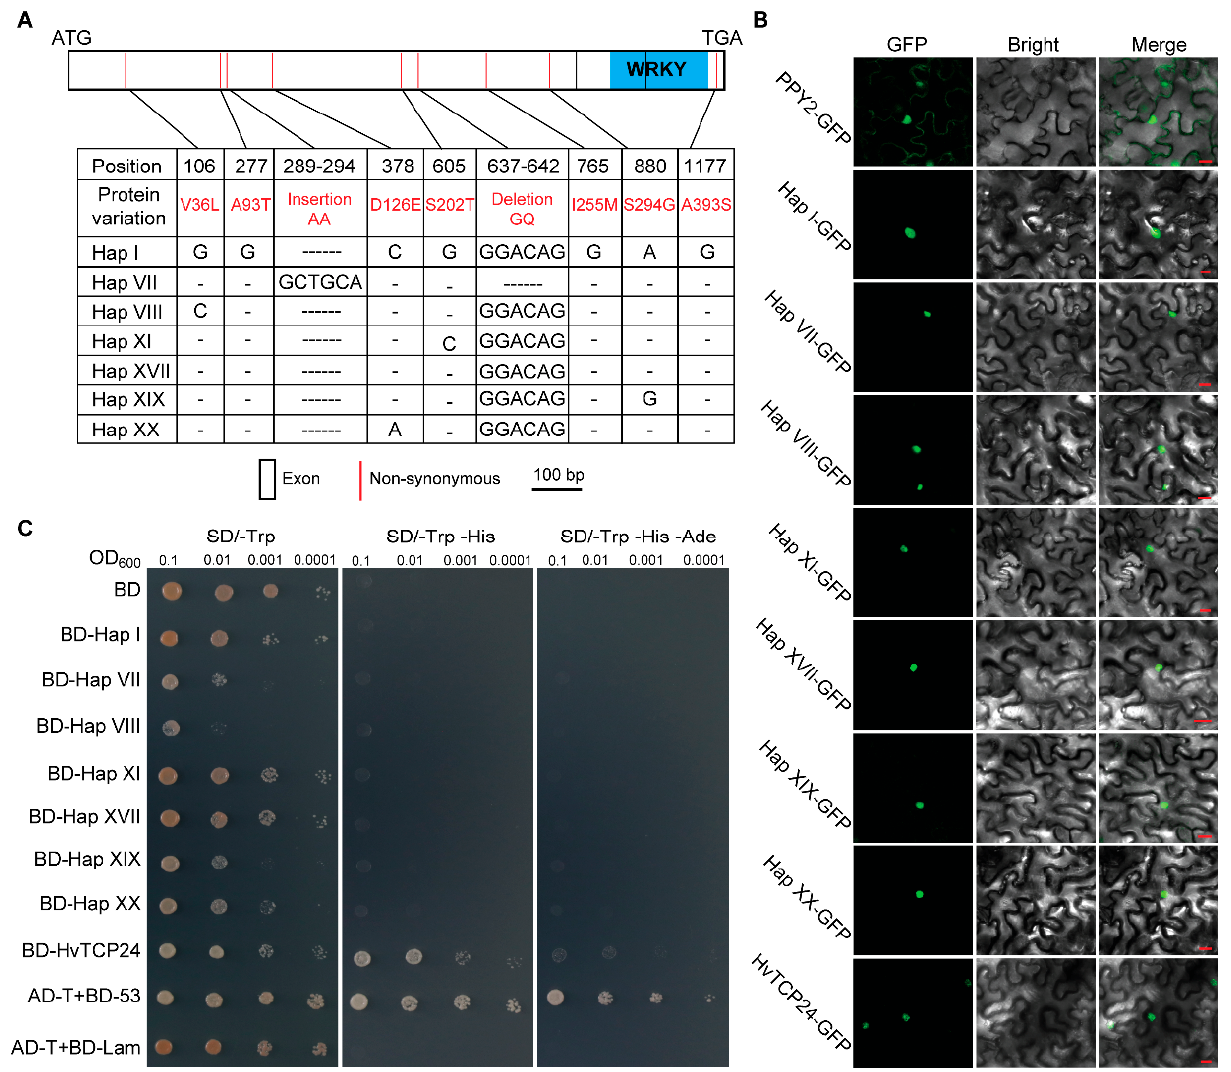
Figure 5. The subcellular localization and transactivation activity of WRKY9 haplotypes. ( A ) Graphical representation of the full-length coding sequence of selected haplotypes. Only non-synonymous substitutions are indicated. The blue rectangle represents the WRKY domain. ( B ) Subcellular localization of WRKY9 haplotypes in N. benthamiana . Scale bar = 20 µ m. ( C ) Transactivation activity of WRKY9 haplotypes in yeast. BD-HvTCP24, which contains a transactivation activity in yeast, serves as a positive control. SD, synthetic dextrose medium; Trp, tryptophan; His, histidine; Ade, Adenine. 0.1, 0.01, 0.001 and 0.0001 denoted the different dilution series.